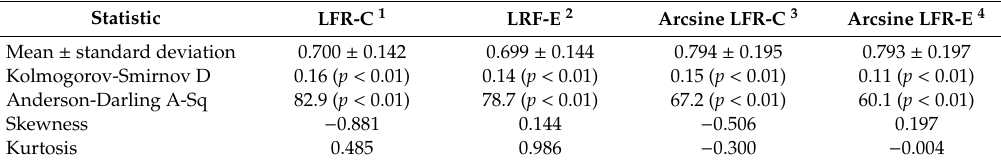
Table 3. Descriptive statistics for lifetime fertility rate (LFR), normality tests (Kolmogorov-Smirnov D and Anderson Darling A-Sq parameters and significance), skewness, and kurtosis of the 3033 data in the full data set obtained combining actual and predicted number of foals after 6 breeding seasons and considering di ff erent prediction methods.